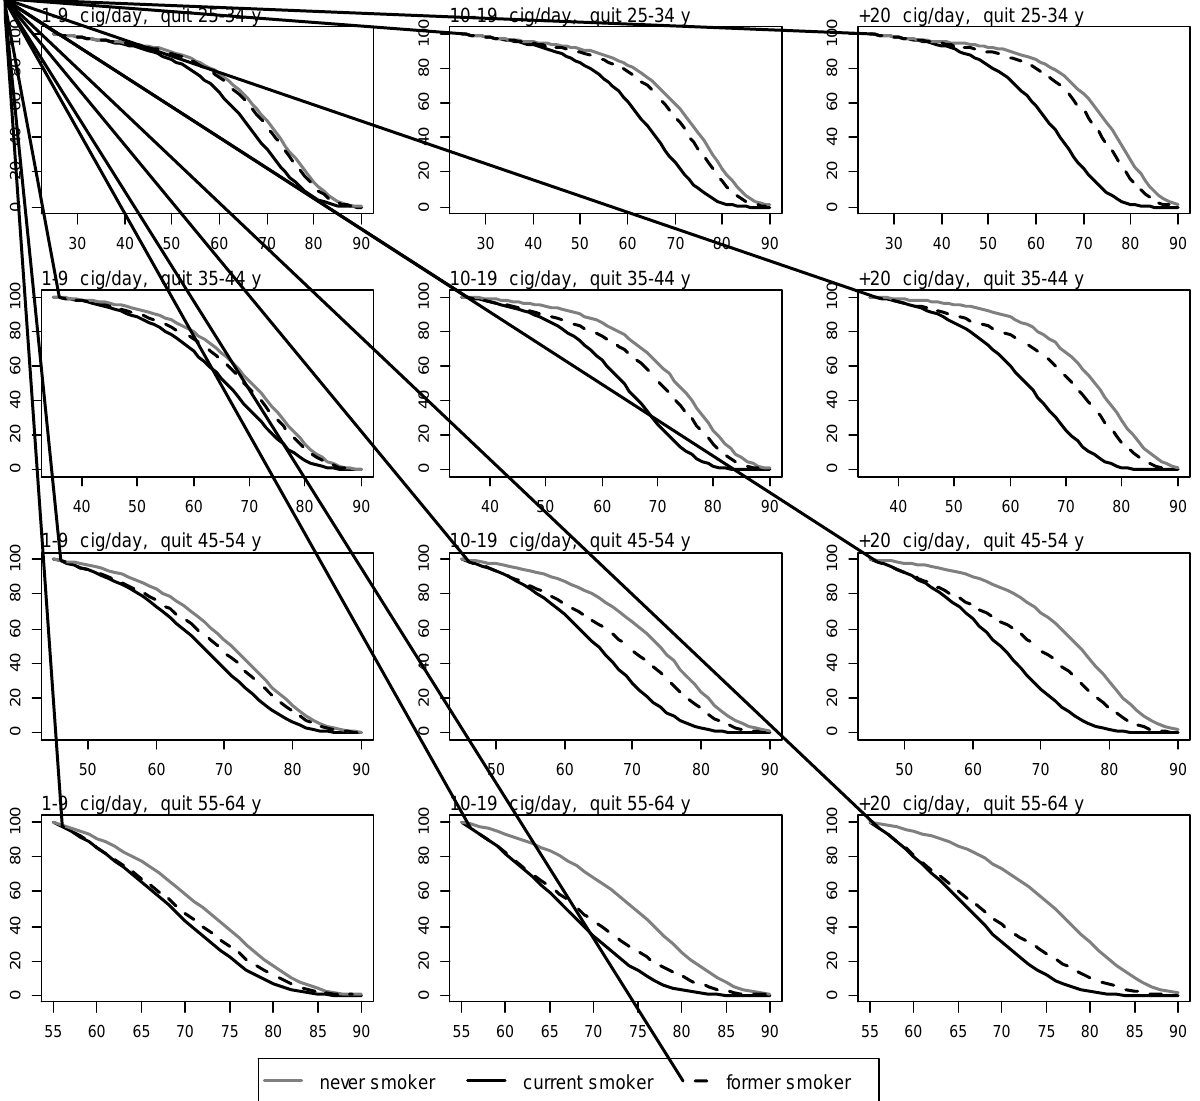
Figure 3. Survival for never, current, and former men smokers by number of cigarettes smoked per day and age of quitting. y axis: proportion of survival. x axis: age in